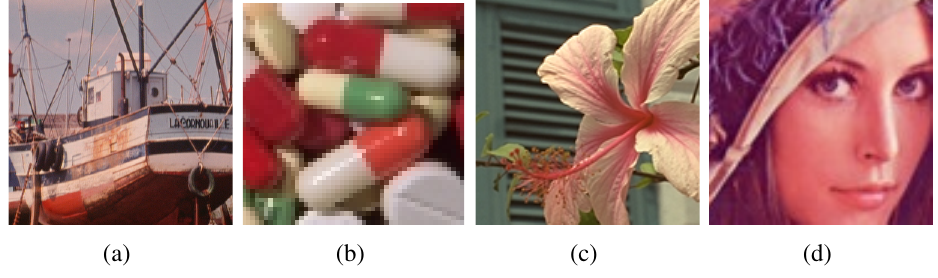
Figure 1. Test images: (a) Boats, (b) Pills, (c) Flower, and (d)